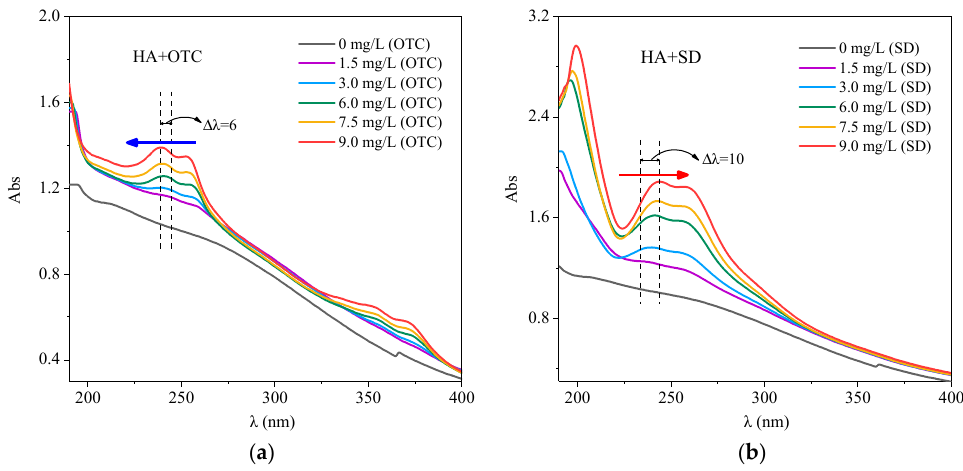
Figure 1. The interactions of different concentrations of OTC and SD with HA ( a ) OTC; ( b ) SD.